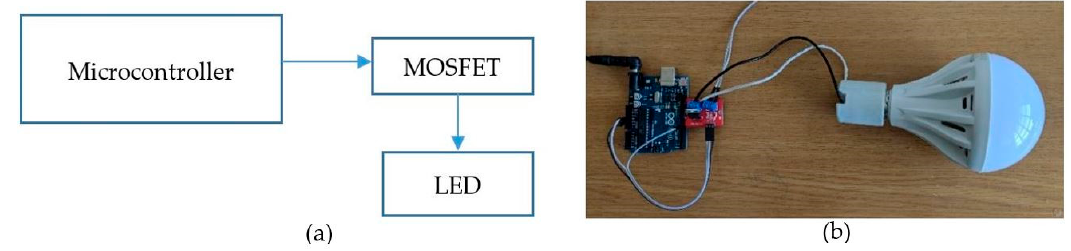
Figure 19. Transmitter implementation architecture. ( a ) Circuit diagram. ( b ) Devices demo.